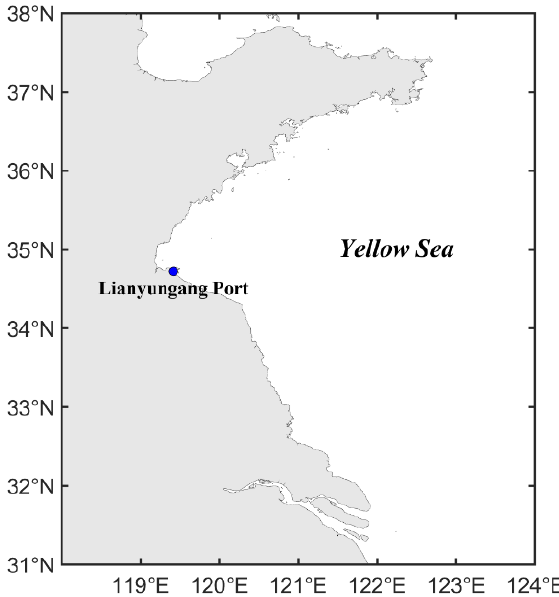
Figure 4. The location of Lianyungang Port.